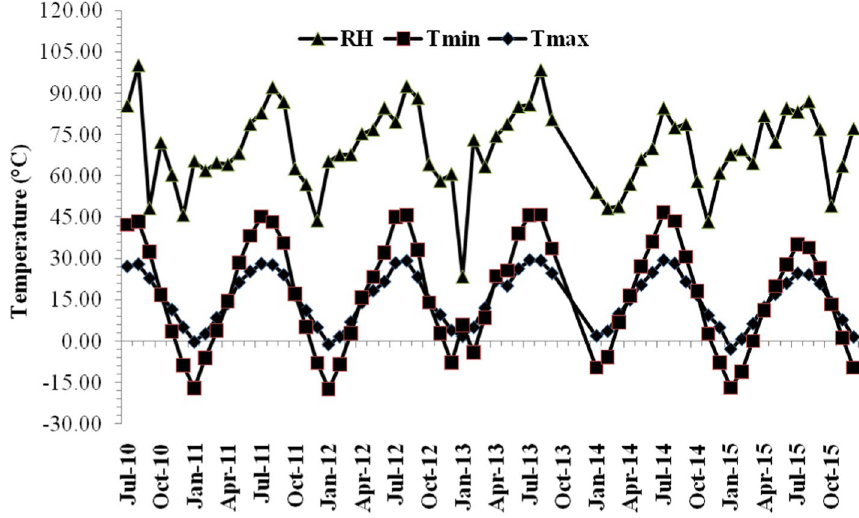
Fig. 8 Variation of relative humidity (RH), maximum temperature ( T max ), and mini- mum temperature ( T min ) of six consecutive years (2010–2015) at experimental location of Leh, Ladakh, Kashmir (Bharti et al. 2017a,